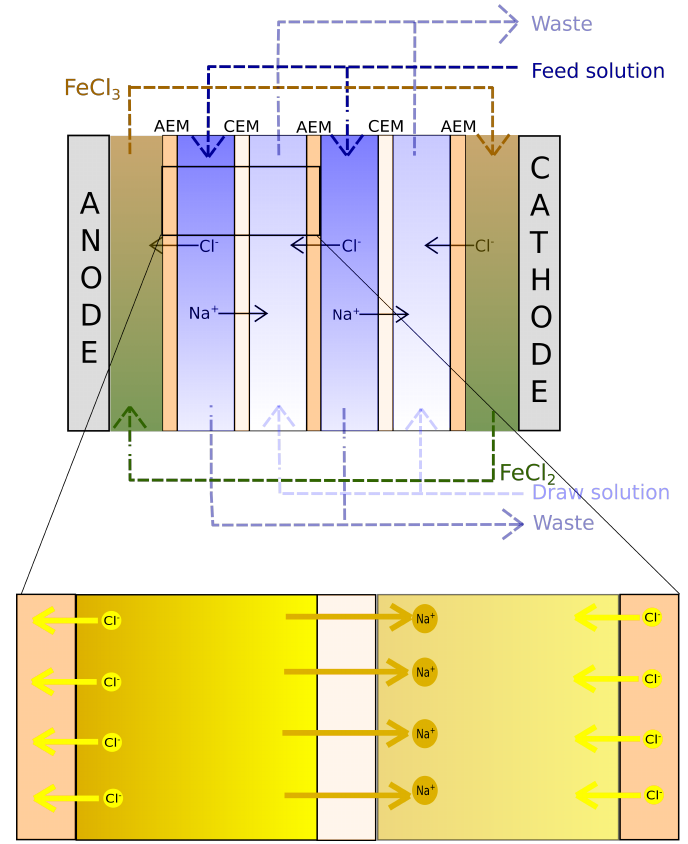
Figure 1. Illustration of ion distribution in the concentrated and dilute streams of a RED stack consisting of AEMs, CEMs, and concentrated and dilute solution channels. FeCl 2 and FeCl 3 are the electrode rinse solutions